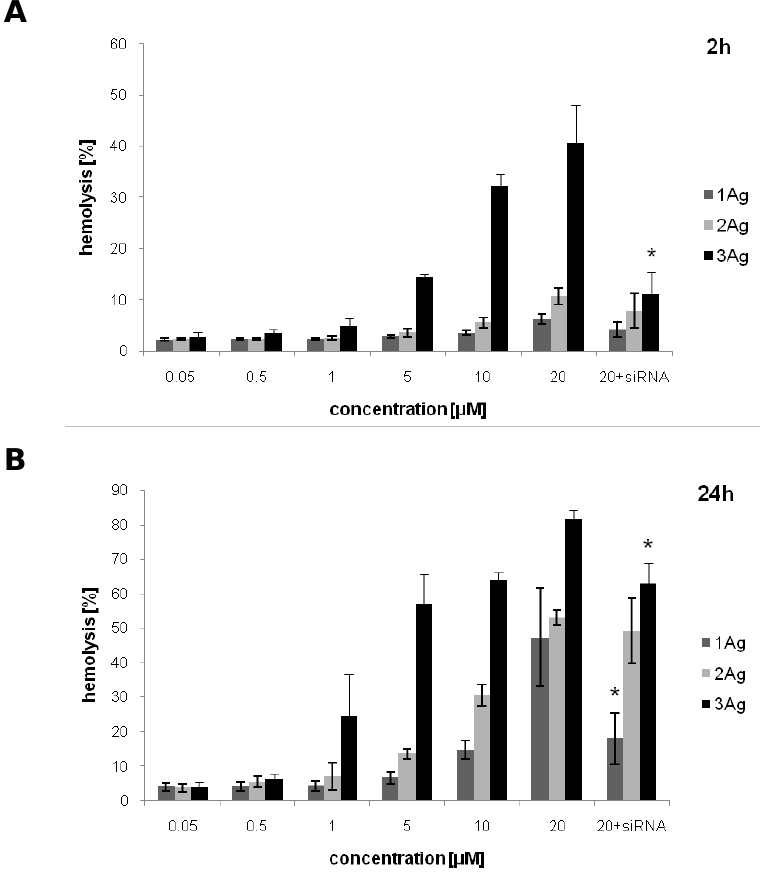
Figure 8. Hemolysis induced by AgNPs and their complexes with siRNA (siBcl-xl) after 2 ( A ) and 24 h of incubation ( B ). The abscissa values refer to the dendron concentration. Data presented as the percentage of hemolysis, mean ± SD, n = 4. *Statistically significant differenc e compared to free nanoparticle at p < 0.05.